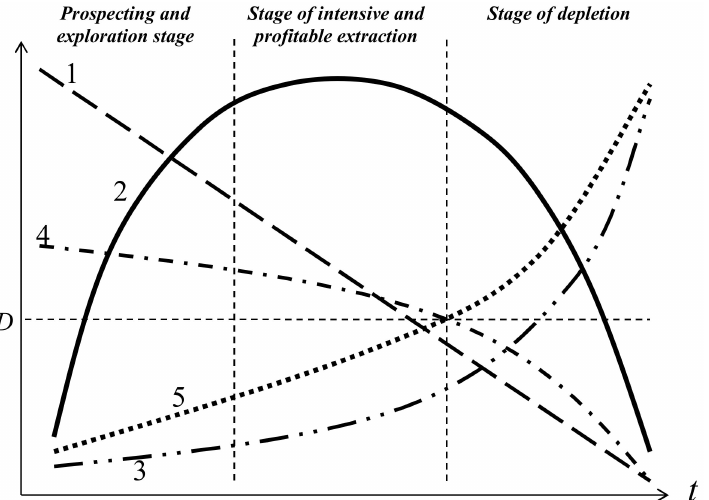
Figure 1. Stages of mineral development and characteristic changes in indicators of the min- eral resources and geological environment state 1—The ratio of inferred resources to minable reserves; 2—Total return on investment in exploration and operation; 3—The degree of involve- ment of secondary resources and substitutes; 4—Stability of the geological environment; 5—Costs for environmental protection and rehabilitation of territories; D—Assimilation potential of the geological